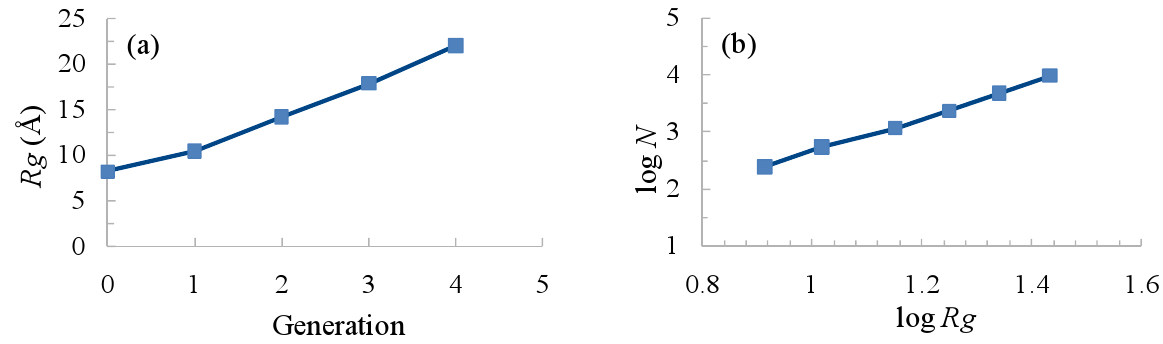
Figure 7. ( a ) Relationship between radius-of-gyration R G BPO (n = 0–4). ( b ) Relationship between the number of atoms ( N ) of dendrimers and the R n